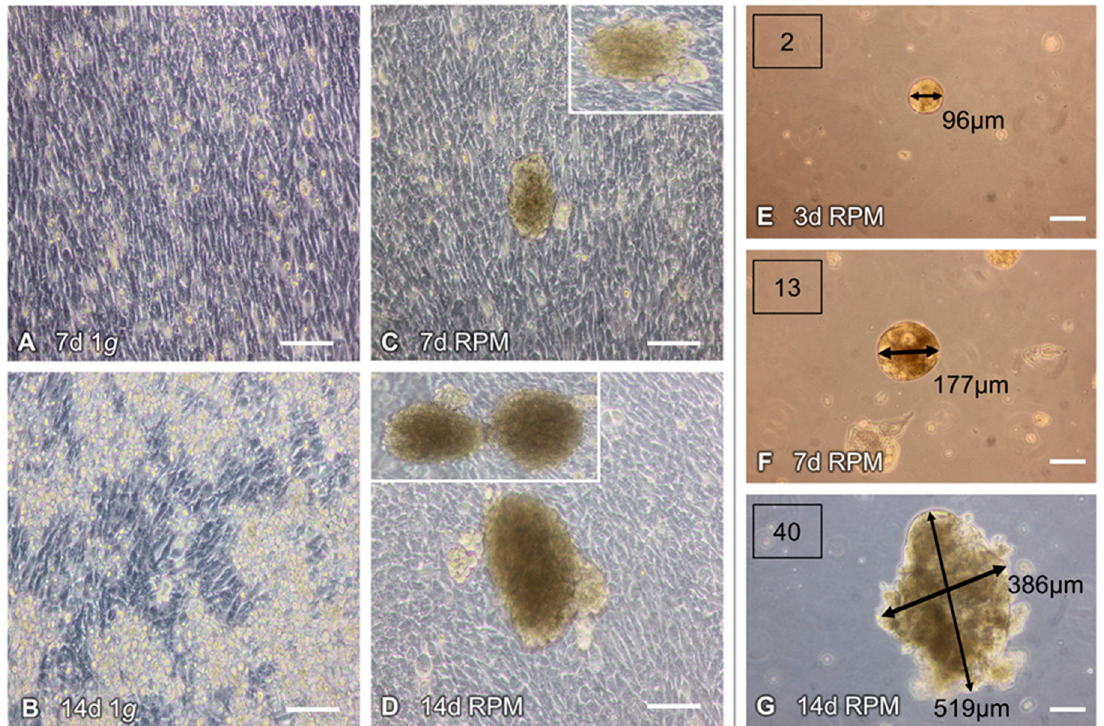
Figure 1. Random Positioning Machine (RPM)-induced formation of 3D multicellular spheroids (MCS) of human foetal osteoblasts (hFOB 1.19): Under static 1 g conditions, the cells grew adherently and remained in confluent monolayer cultures, when incubated for ( A ) 7 days and ( B ) 14 days. ( C , D ) Exposed to an RPM, the cells assembled into 3D aggregates, with the MCS increasing, over time, in size and number. ( E ) Microscopic analyses showed 2 MCS in the field of view, with an average diameter of 96 µ m, after 3 days. After 7 days ( F ) and 14 days ( G ) cultivation on the RPM, the numbers of the spheroids increased from 13 to 40 MCS per field of view. The spheroids were 386 × 519 µ m tall, after 14 days. The white squares in ( C ) and ( D ) show other examples of MCS. Scale bars: 100 µ m; d, days.